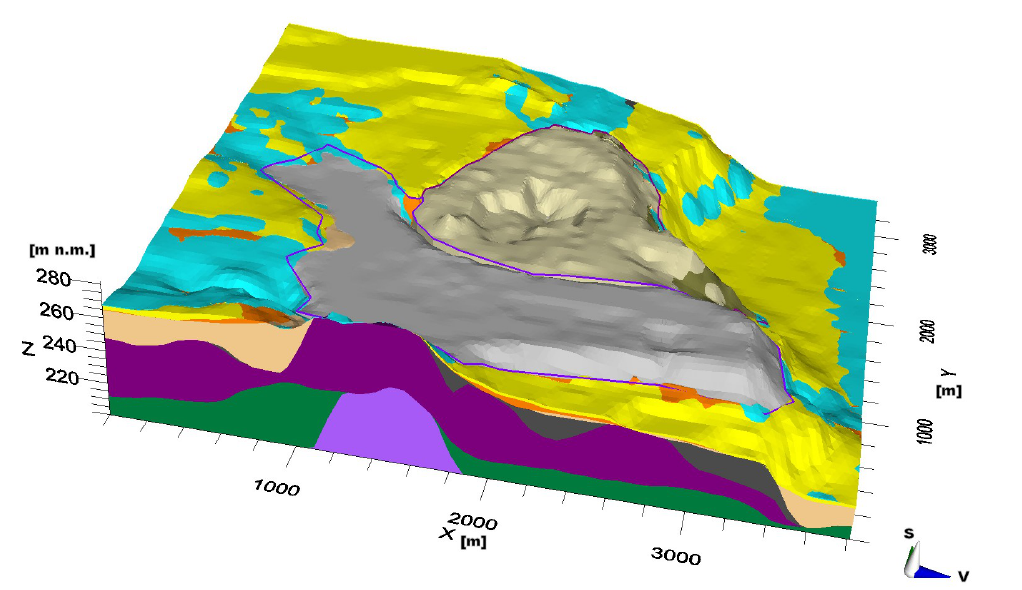
Figure 1. Initial geological model (superelevated 10